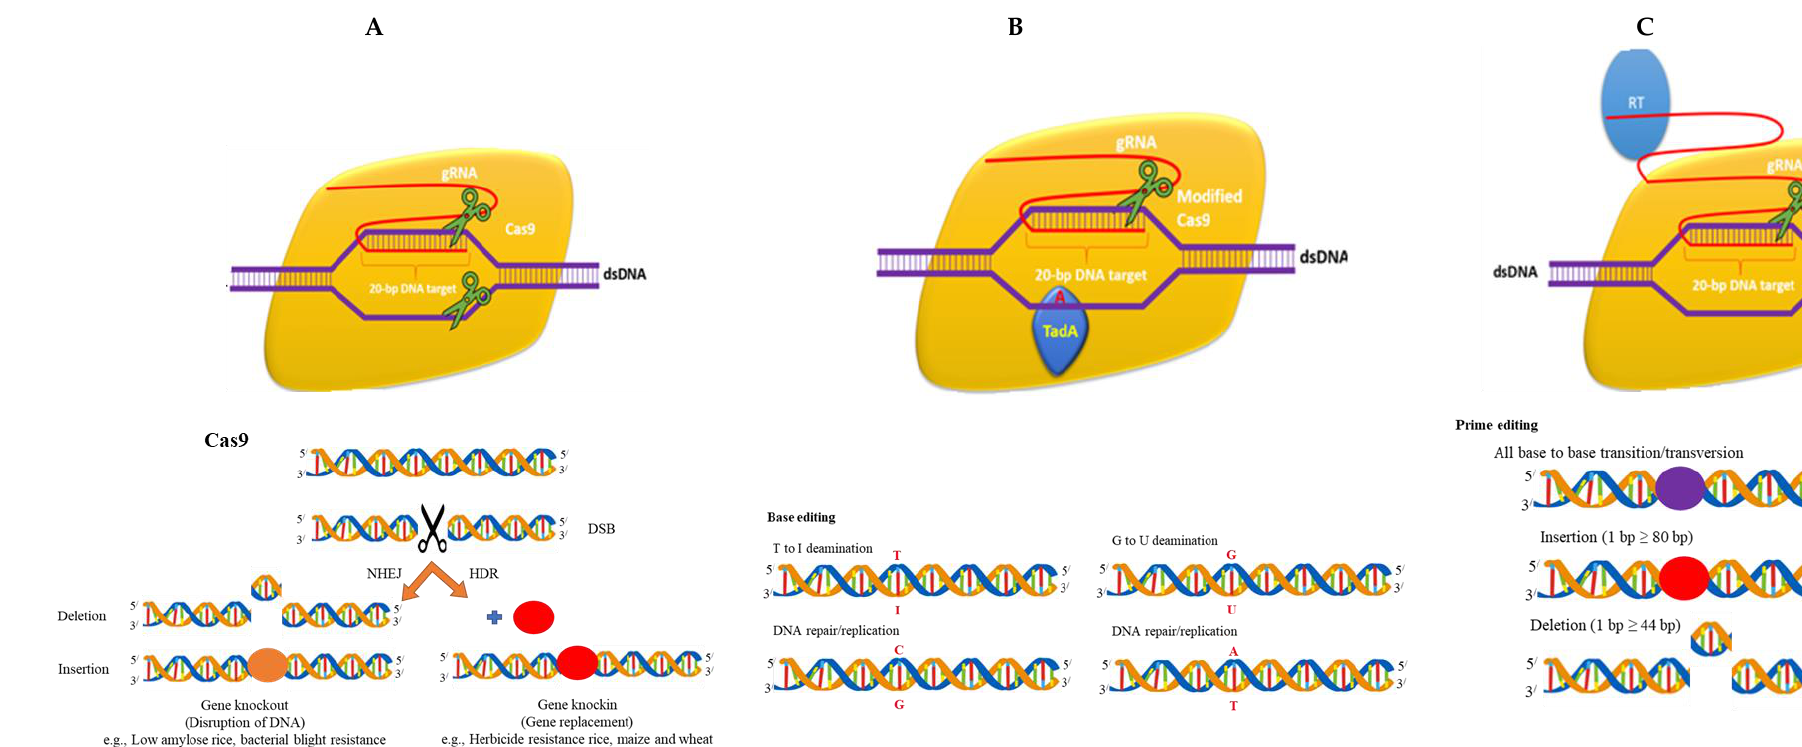
Figure 3. CRISPR/Cas reagents: ( A ) traditional Cas9 reagent; ( B ) CRISPR/Cas base editor; ( C ) prime editor.